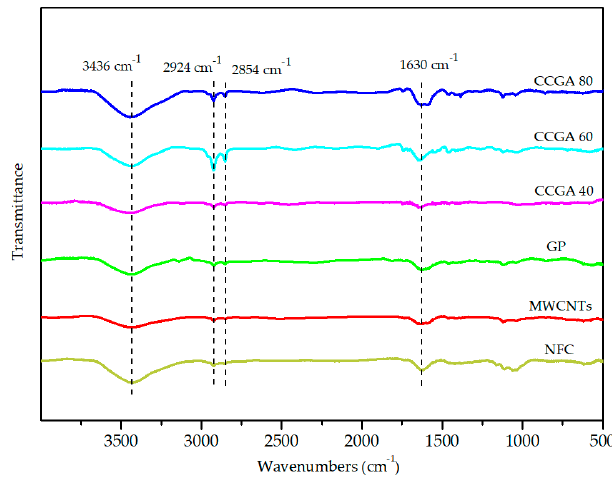
Figure 7. FT-IR spectra of the different aerogels. Table 1. pH of the suspension with different NFC contents.